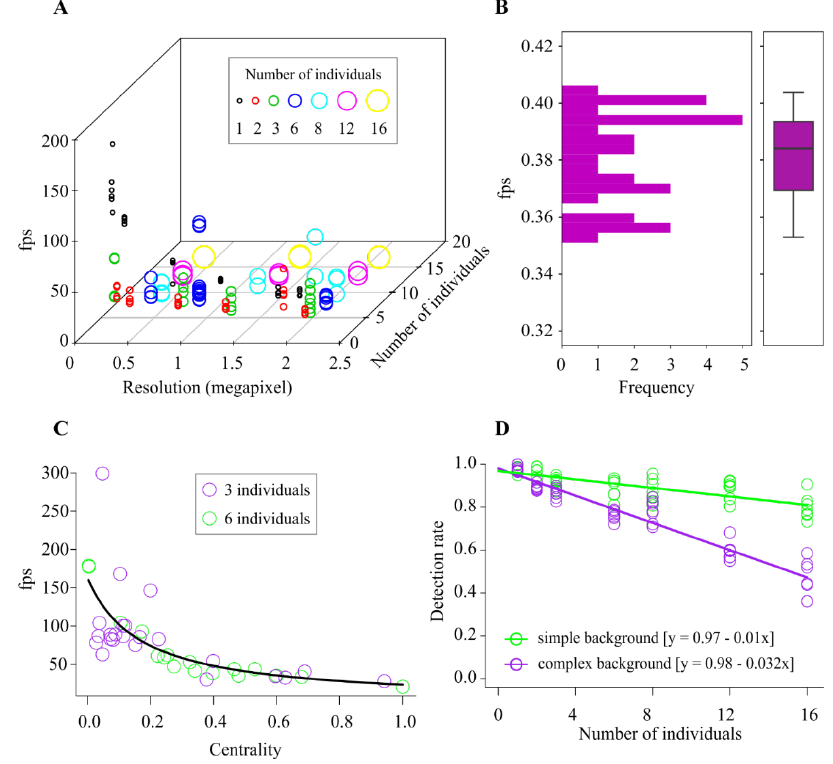
Figure 10. Quantification of the performance of Ethoflow. ( A ) Frames per seconds (fps) response to the video resolution (in pixels) and the number of individuals in homogeneous backgrounds; the dots ( n = 134) represent the raw data. ( B ) Histogram of the fps in heterogeneous environments ( n = 30). The box plot indicates the median and range of dispersion (lower and upper quartiles and outliers). ( C ) Fps in response to centrality. The proportion of group interaction per frame was used to quantify the centrality ( n = 40). ( D ) Accuracy of the software as a function of the interaction between the number of individuals and type of environment (homogeneous and heterogeneous); the symbols represent the raw data (circles; n = 98).